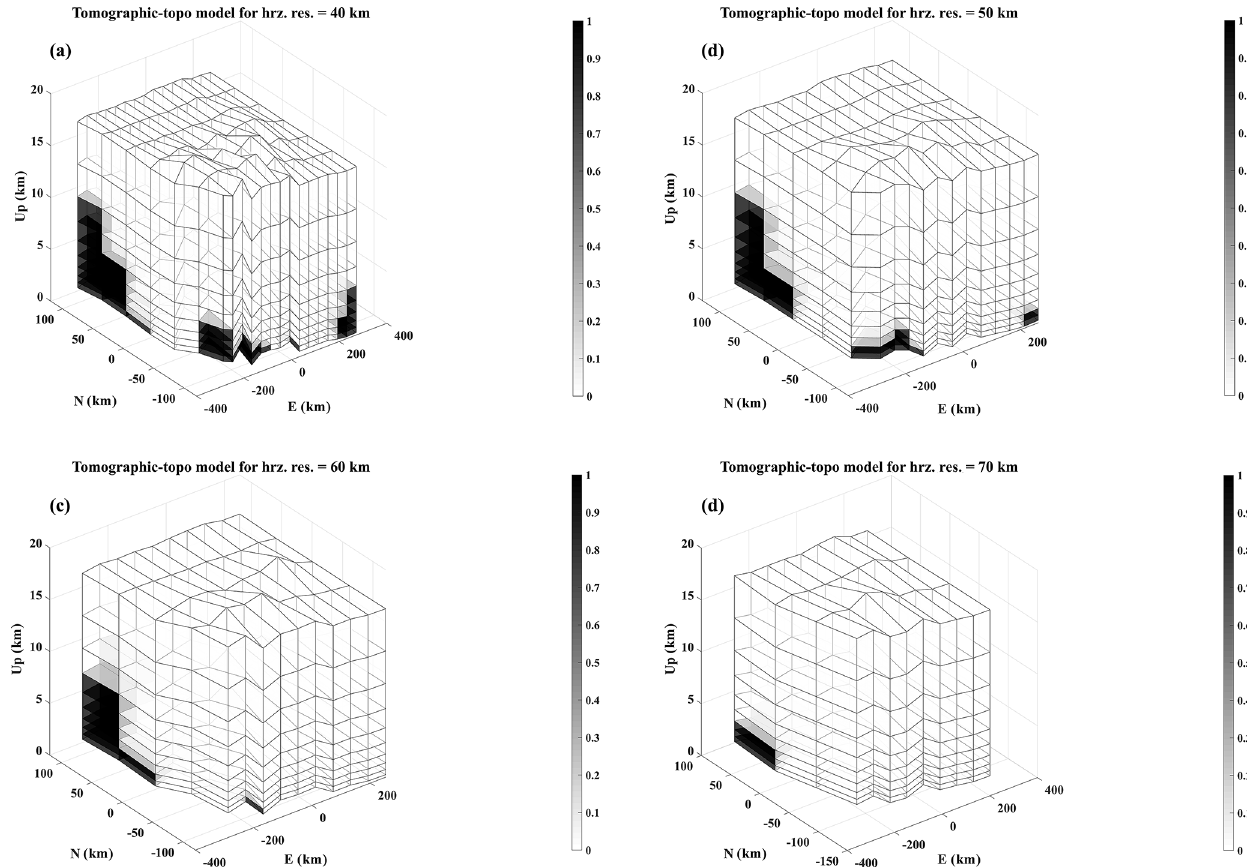
Figure 4. The tomography model for the horizontal resolutions of (a) 40km, (b) 50km, (c) 60km and (d)